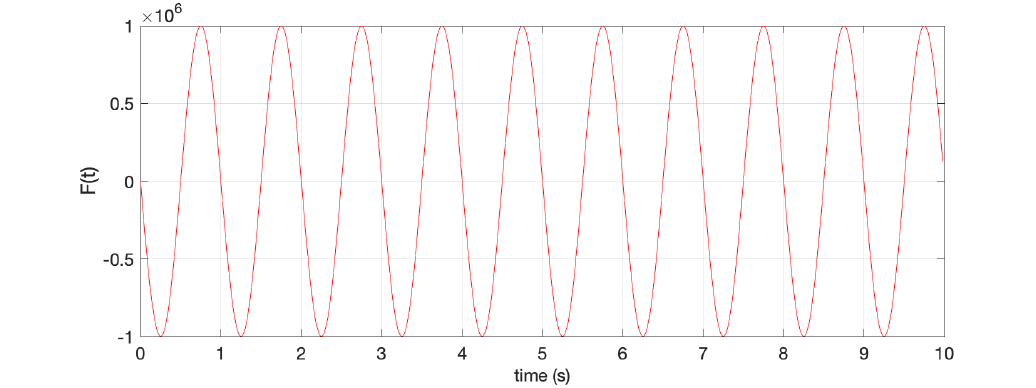
Figure 2. Harmonic